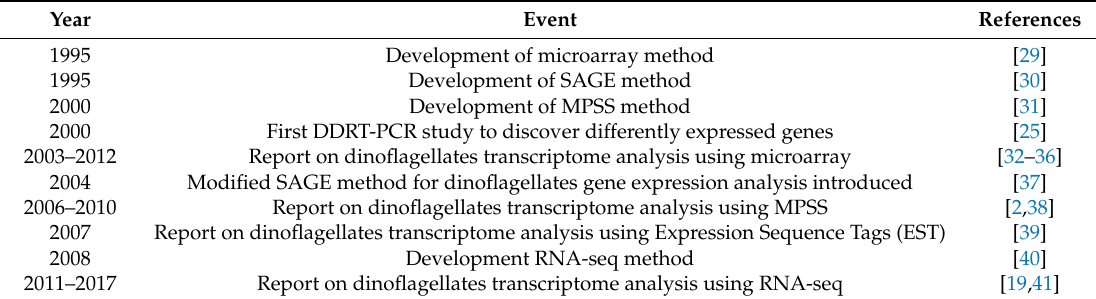
Table 2. A brief history in dinoflagellates transcriptome